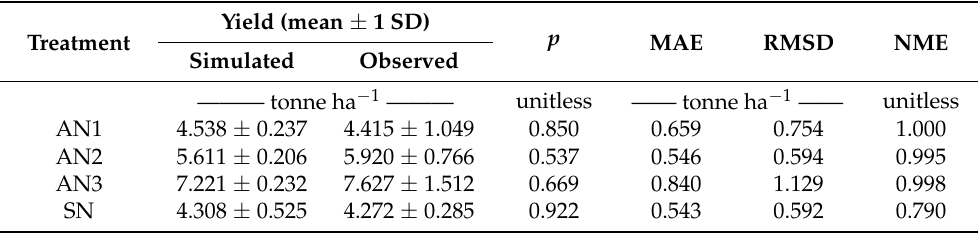
Table 4. Observed versus simulated wheat grain yields for the different treatments in terms of the p -value shown by the t-test, the mean absolute error (MAE), the root mean squared deviation (RMSD), and normalised Nash–Sutcliffe model efficiency (NME).